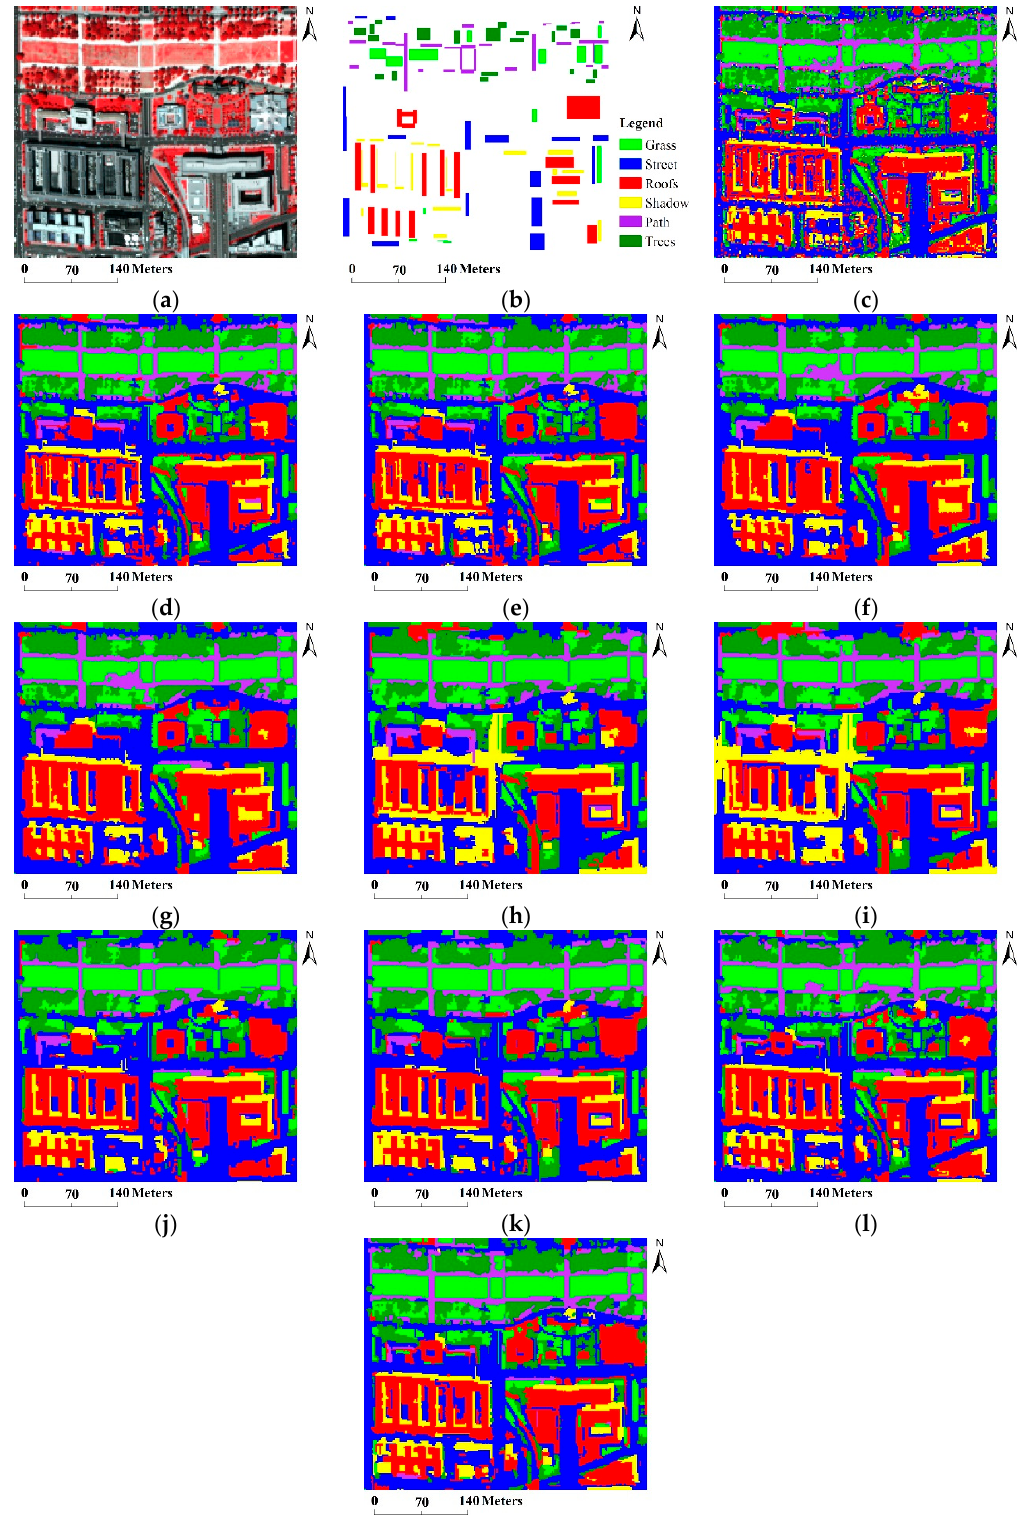
Figure 9. Classification maps for the Washington DC data set: ( a ) RGB colour composite (bands 63, 52, and 36); ( b ) Ground truth data; ( c ) SVM; ( d ) Proba-M-HSEG; ( e ) Proba-M-HSEG +MV; ( f ) Morph-M-HSEG; ( g ) Morph-M-HSEG +MV; ( h ) Proba-M-MSF using ED; ( i ) Proba-M-MSF using SAM; ( j ) Proba-M-MSF +MV using ED; ( k ) Proba-M-MSF +MV using SAM; ( l ) AMG-M-HSEG using ED; and ( m ) AMG-M-HSEG using